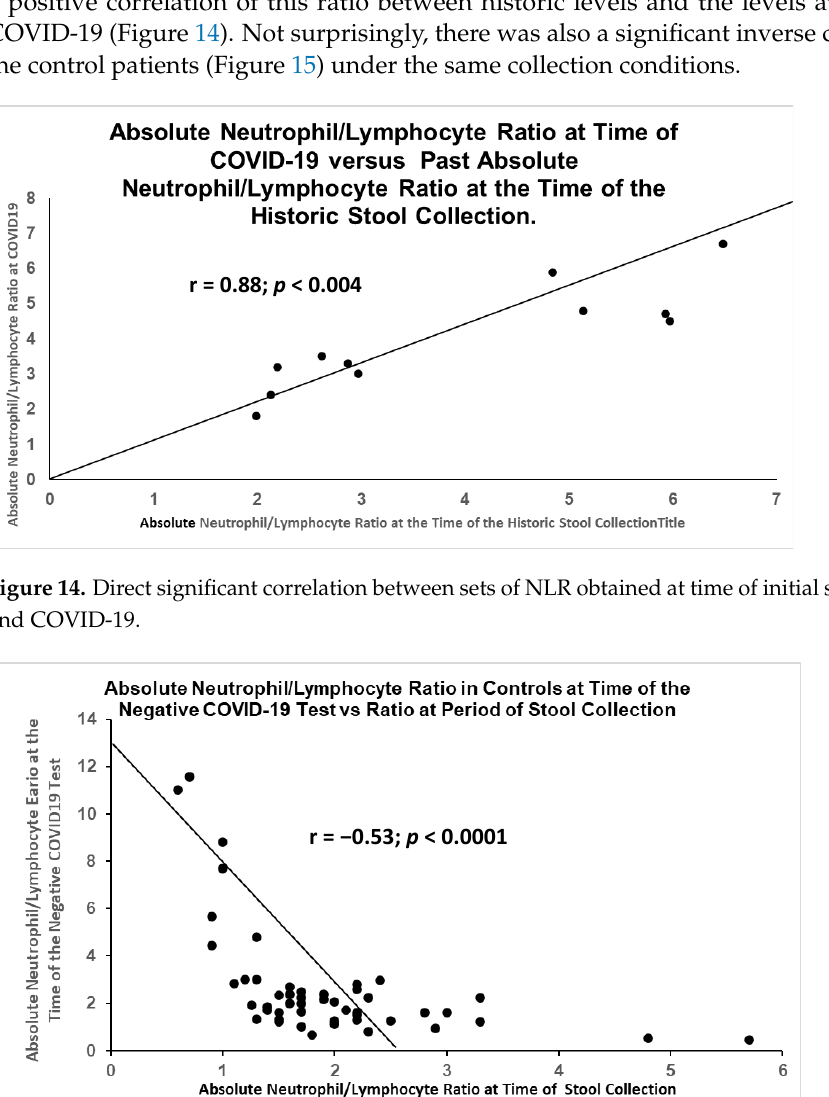
Figure 13. Mean FERAD ratios increased with the severity of COVID-19.